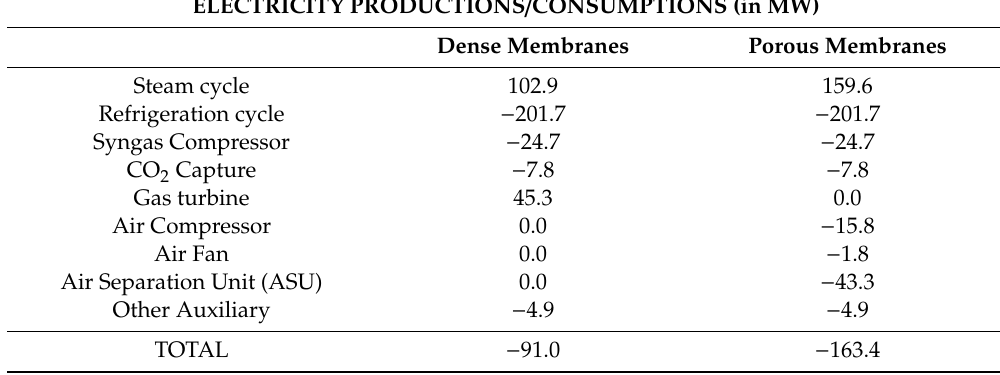
Table 6. Production (positive) and consumption (negative) of electricity (in MW) in the OCM plant for the dense membrane reactor and porous membrane reactor